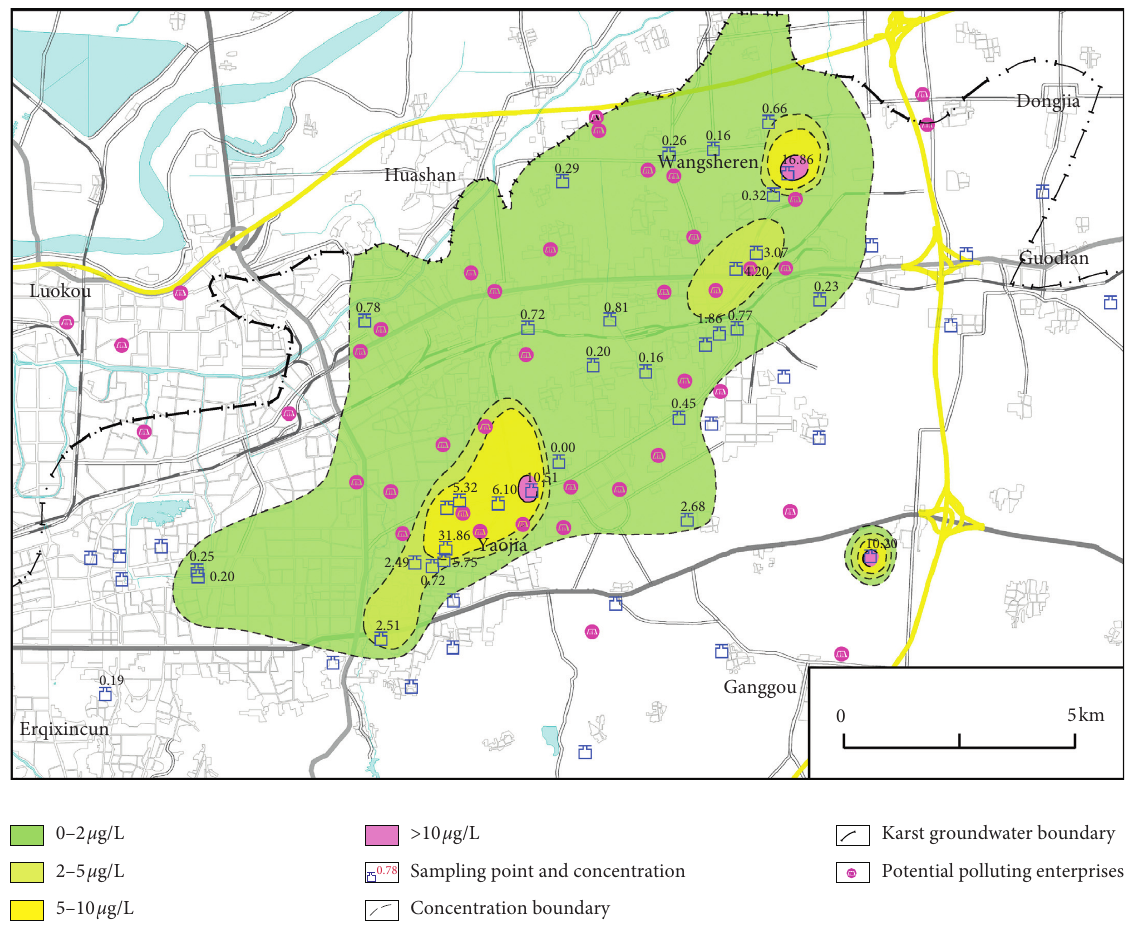
Figure 8: Distribution of the carbon tetrachloride concentration in fractured karst water in northeast spring